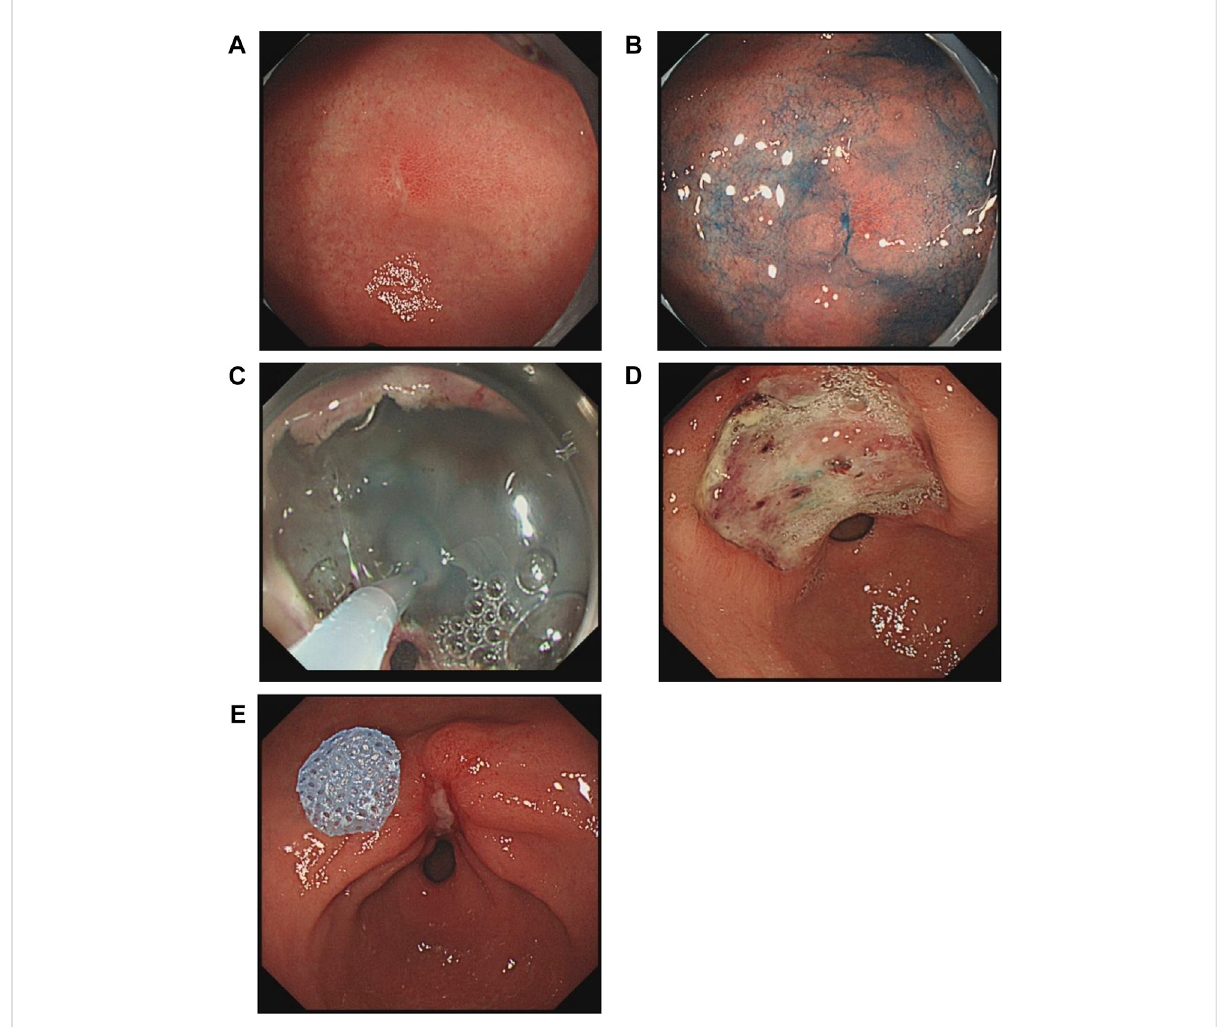
FIGURE 1 Changes in a gastric antral ulcer induced by endoscopic submucosal dissection (ESD) in a gel-treated patient. (A) , An early-stage cancer on the lesser curvature of the antrum. (B) , Endoscopic image after spraying with indigo-carmine dye. (C) , Application of gel to the ulcer immediately after ESD. (D) ,TheulcerwasintheactivestageaccordingtotheSakitaandFukutomiclassi fi cationat3 daysafterESD. (E) ,Thehealingstagewasobserved at 28 days after